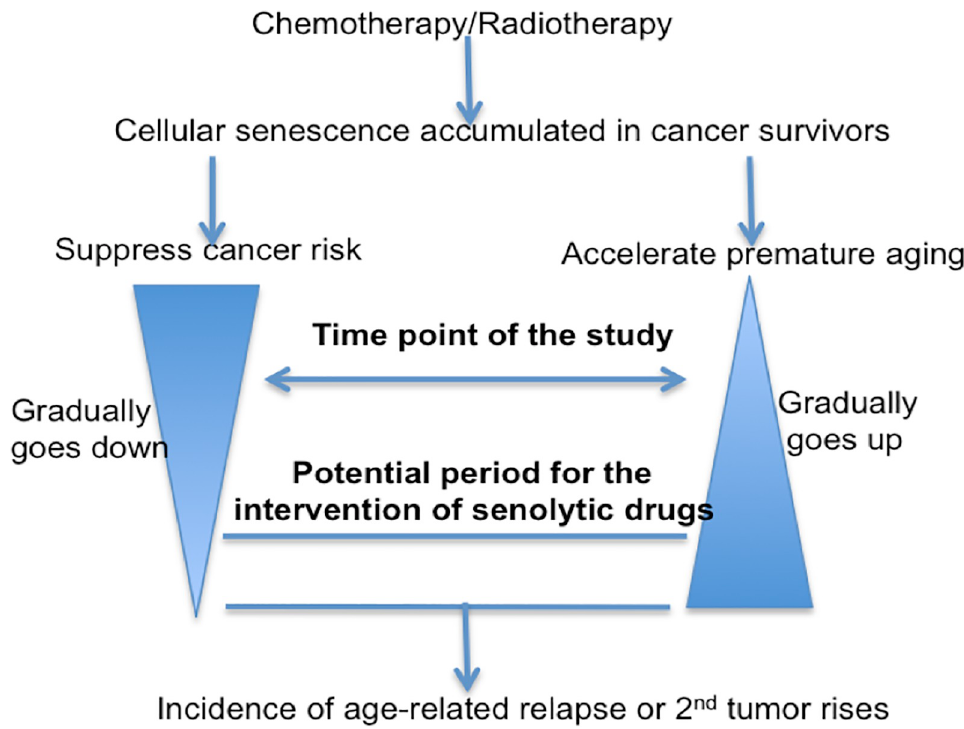
Fig 5. Model for the role of therapy-induced senescence in tumorigenesis. Senescence accumulated after chemotherapy/Radiotherapy leads to suppression of cancer and premature aging. As therapy-recipients age, the impact on the suppression gradually goes down, whereas the impact on aging gradually goes up. After reaching certain point, age-related cancer incidence rises in the long-term cancer survivors. Time point of our study and potential period for the intervention of senolytic drugs in order to reduce cancer incidence are indicated in the